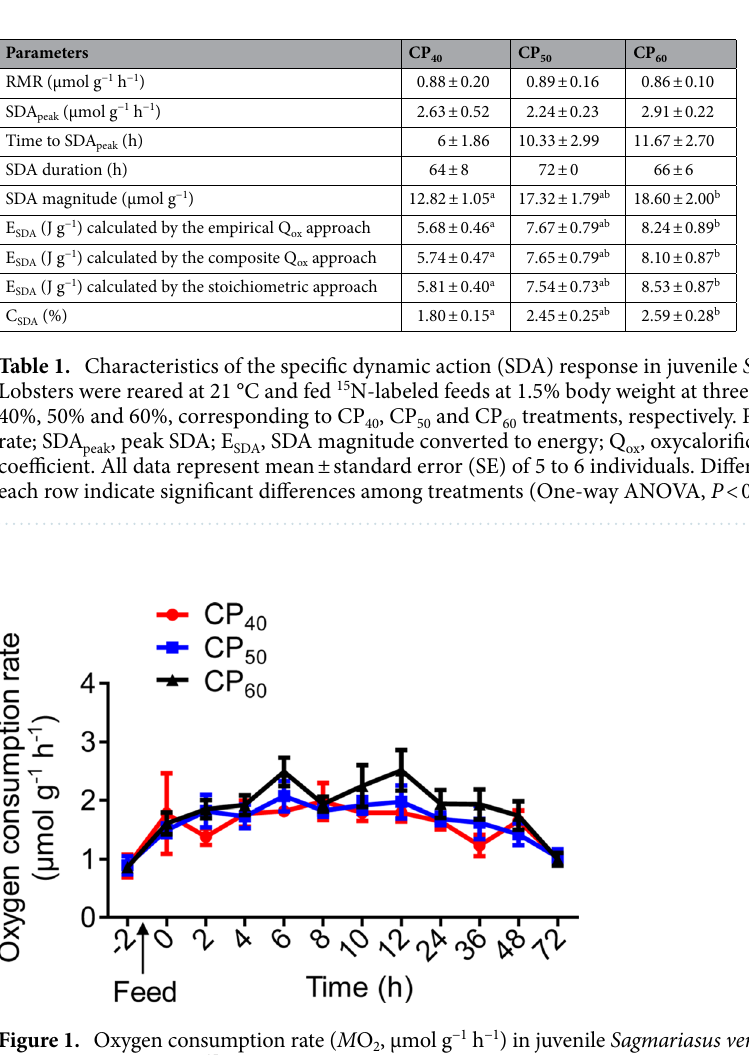
Figure 1. Oxygen consumption rate ( M O 2 , μmol g −1 h −1 ) in juvenile Sagmariasus verreauxi . Lobsters were reared at 21 °C and fed 15 N-labeled feeds at 1.5% body weight at three crude protein levels: 40%, 50% and 60%, corresponding to CP 40 , CP 50 and CP 60 treatments, respectively. The M O 2 at − 2 h indicates the routine metabolic rate (RMR). The first post-prandial M O 2 was recorded at 0 h. All data represent mean ± standard error (SE) of 6 individuals.